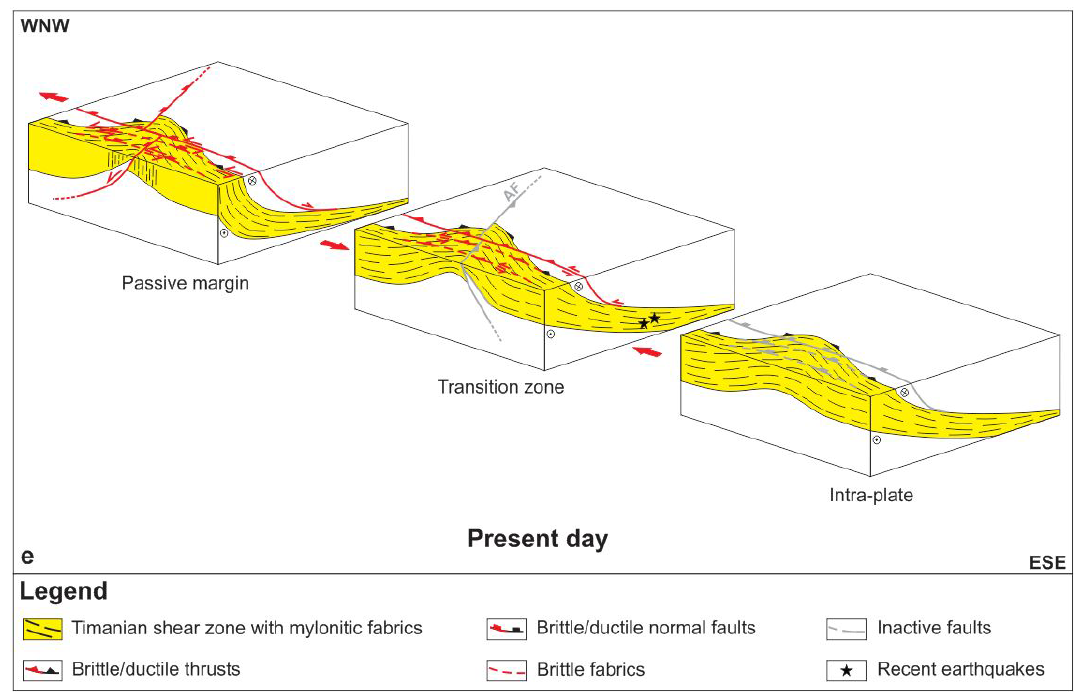
Figure 7. Tectonic evolution of Timanian thrust systems in eastern and southern Spitsbergen, Storfjorden, and the northern Norwegian Bar- ents Sea including (a) top-SSW thrusting during the Timanian Orogeny, (b) reactivation as oblique-slip sinistral–reverse thrusts and offset by N–S-striking brittle thrust overprints (e.g., Agardhbukta Fault – AF) under E–W contraction during the Caledonian Orogeny, (c) reactivation as low-angle, brittle–ductile, normal–sinistral extensional detachments and overprinting by high-angle normal–sinistral brittle faults during Devonian–Carboniferous, late–post-Caledonian extensional collapse and rifting, (d) reactivation as brittle–ductile sinistral–reverse thrusts, overprinting by high-angle sinistral–reverse brittle thrusts, and mild offset by reactivated N–S-striking thrusts (e.g., Agardhbukta Fault – AF) during E–W Eurekan contraction (note the absence of reactivation and overprinting away from the margin), and (e) renewed, recent– ongoing, sinistral–reverse reactivation and overprinting possibly due to ongoing magma extrusion and transform faulting (ridge-push?) in the Fram Strait, i.e., normal–sinistral along the Fram Strait passive margin and reverse–sinistral in the transition zone (e.g., Storfjorden and eastern Spitsbergen). Notice the relatively higher deformation intensity of Timanian thrusts at (paleo-)active and passive margins including sub-vertical geometry prone to accommodate lateral movement (e.g., Vimsodden–Kosibapasset Shear Zone in southern Spitsbergen) and milder reactivation–overprinting away from the margin where Timanian thrusts retained their low-angle geometry (e.g., eastern Spitsbergen, Storfjorden, and central Barents Sea). Folding of Timanian thrusts is also more gentle away from the margin (e.g., central Barents Sea, Olga and Ora